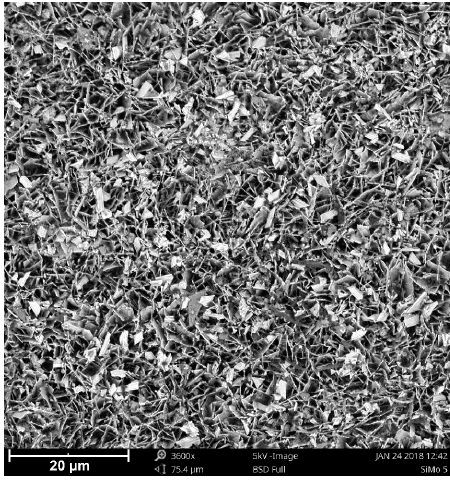
Figure 6. View of the loose oxide layer on a SiMo 5 sample. SEM.